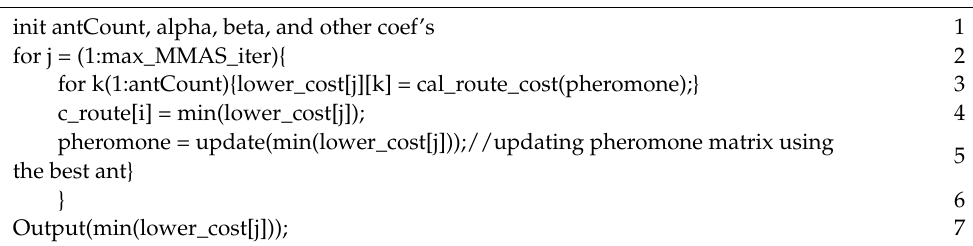
Algorithm 2 The max–min ant system